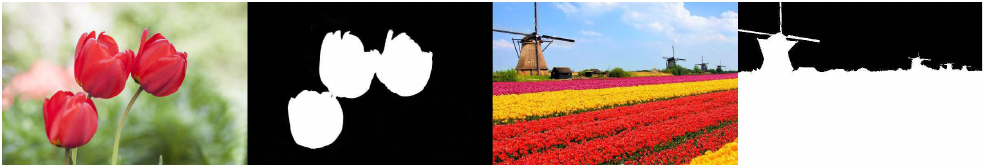
Figure 1. Example of close-up images (on the left), large field images (on the right) and the corre- sponding ROI map (the binary images).